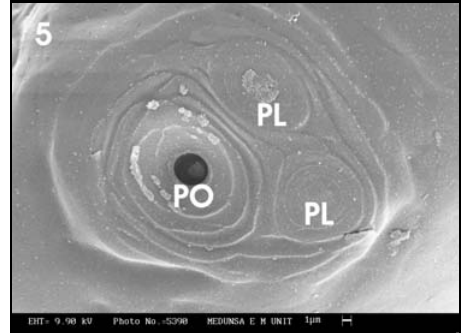
coeloconica.Fig.